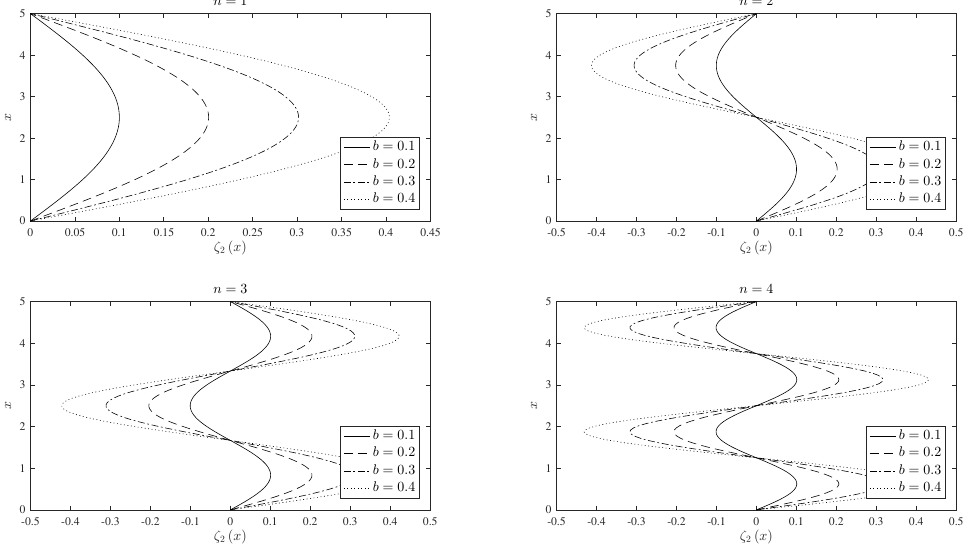
Figure 14. Different mode shapes of the buckled elastic pinned beam for the four lowest buckling forces, n = 1, . . . ,4, as functions of the indeterminate constant b . The length of the beam is L = 5.